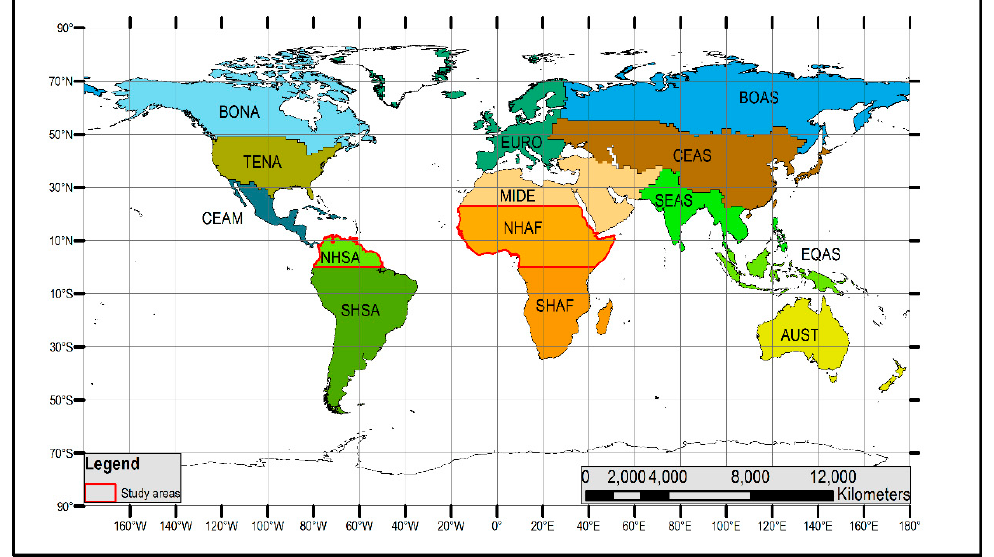
Figure 2. Map of the 14 GFED regions. Regions defined in studies of L. Giglio et al., (2006, 2010) [8,42,49].